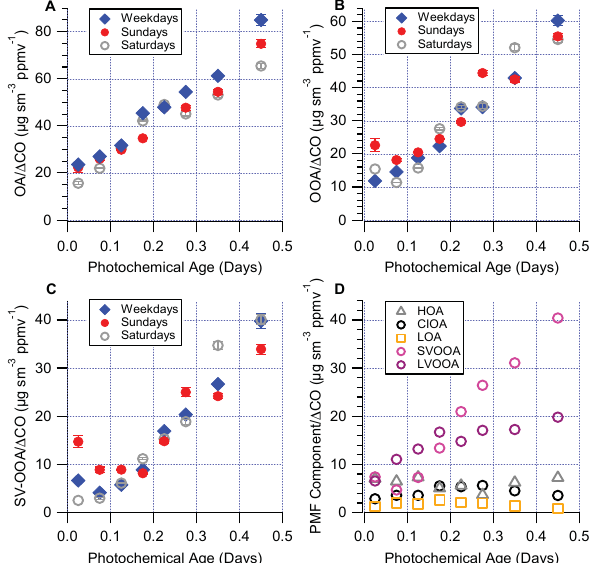
Fig. 1. Measured AMS PMF factor concentrations normalized by CO enhancement ( 1 CO is the ambient CO minus the estimated background CO, 105ppb) as functions of photochemical age (see Hayes et al., 2013 for a detailed description of how this figure was constructed). (A) The evolution of OA/ 1 CO vs. photochemical age for Pasadena during CalNex separated by day of the week. Error bars indicate the standard errors. Photochemical age is determined using the method of Parrish et al. (2007). Also shown are the analo- gous plots for (B) OOA and (C) SV-OOA. (D) Evolution of the PMF component concentrations normalized to 1 CO vs. photochemical